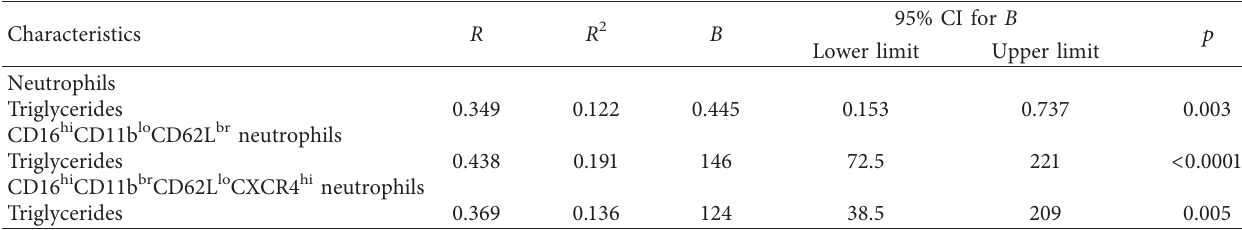
Table 3: Linear regression analysis showing the effect of TG on neutrophil count (adjusted for sex and age).